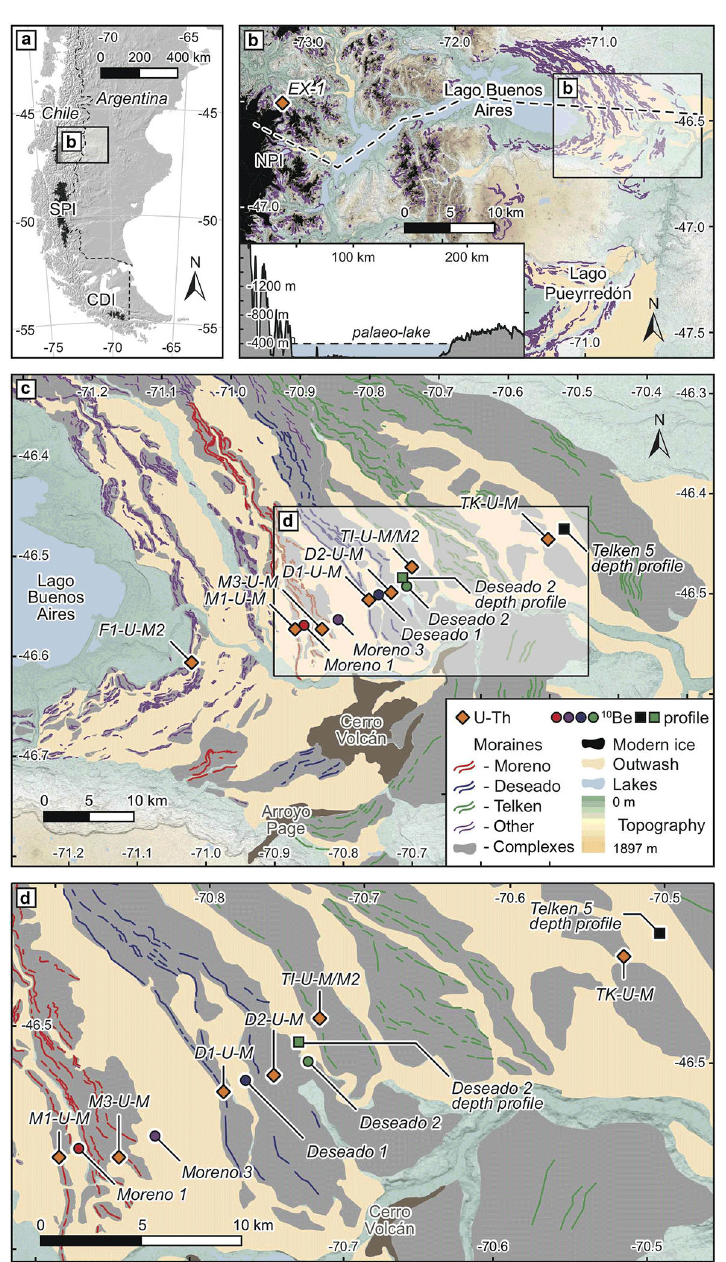
Figure 1. Map of the study area adapted from Bendle et al. (2017). (a) Southern South America showing the location of Lago Buenos Aires. The three main contemporary ice masses in Patagonia are also shown: the Northern (NPI) and Southern Patagonian Ice Field (SPI) and the Cordillera Darwin Ice Field (CDI). (b) Inset shows a west–east transect through the study area from the Patagonian Andes to the frontal moraine systems of the proglacial lake (adapted from Kaplan et al., 2009); sample locations as per (a) . Panels (c) and (d) show the series of frontal moraines sampled in this study. Silt samples are shown by red circles and cobbles and profiles for cosmogenic analysis are shown in blue; the glacial flour sample at the mouth of Los Exploradores glacier is shown, and the extent of the present day ice field is shown in black. Successive glaciations have formed the large overdeepening in which the proglacial lake has